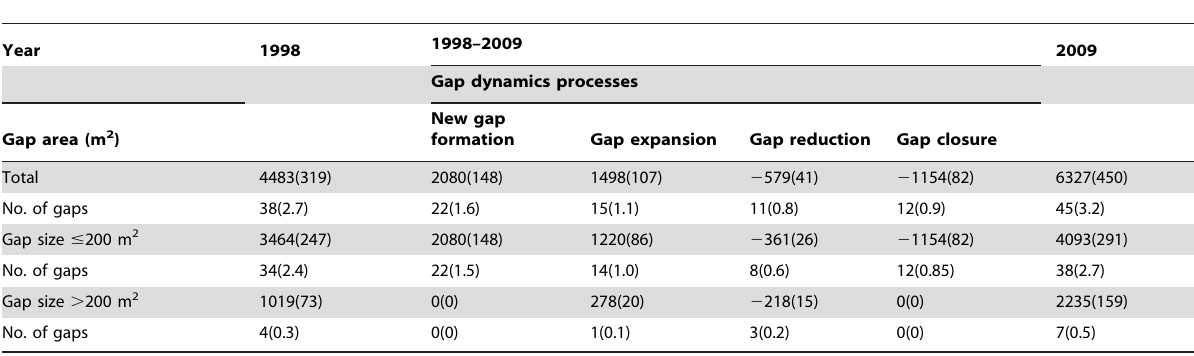
Table 2. Gap characteristics and gap dynamics processes in the Kopa forest reserve.